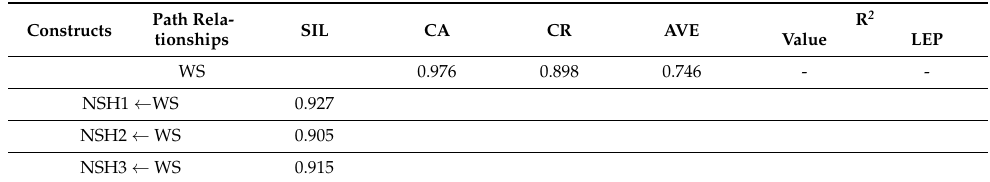
Table 3. Validity, reliability, and value of R 2